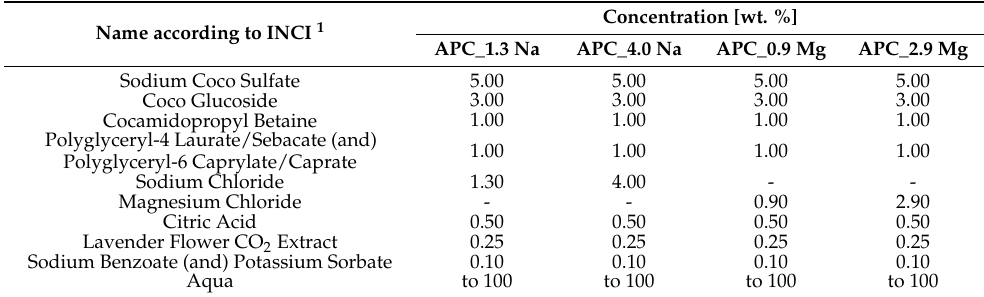
Table 1. Model formulations of APCs.